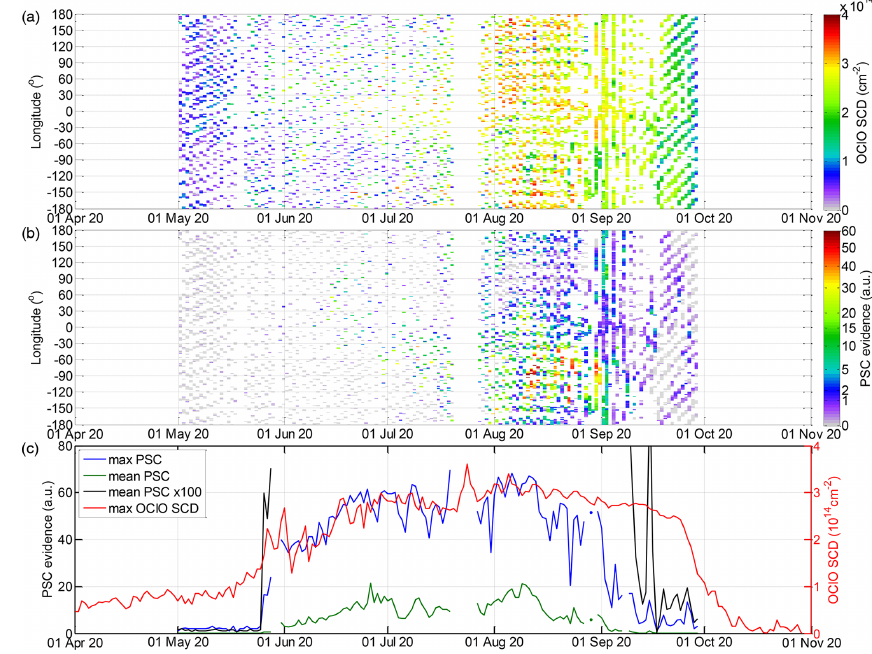
Figure 18. Same as Fig. 3 but for the Antarctic winter